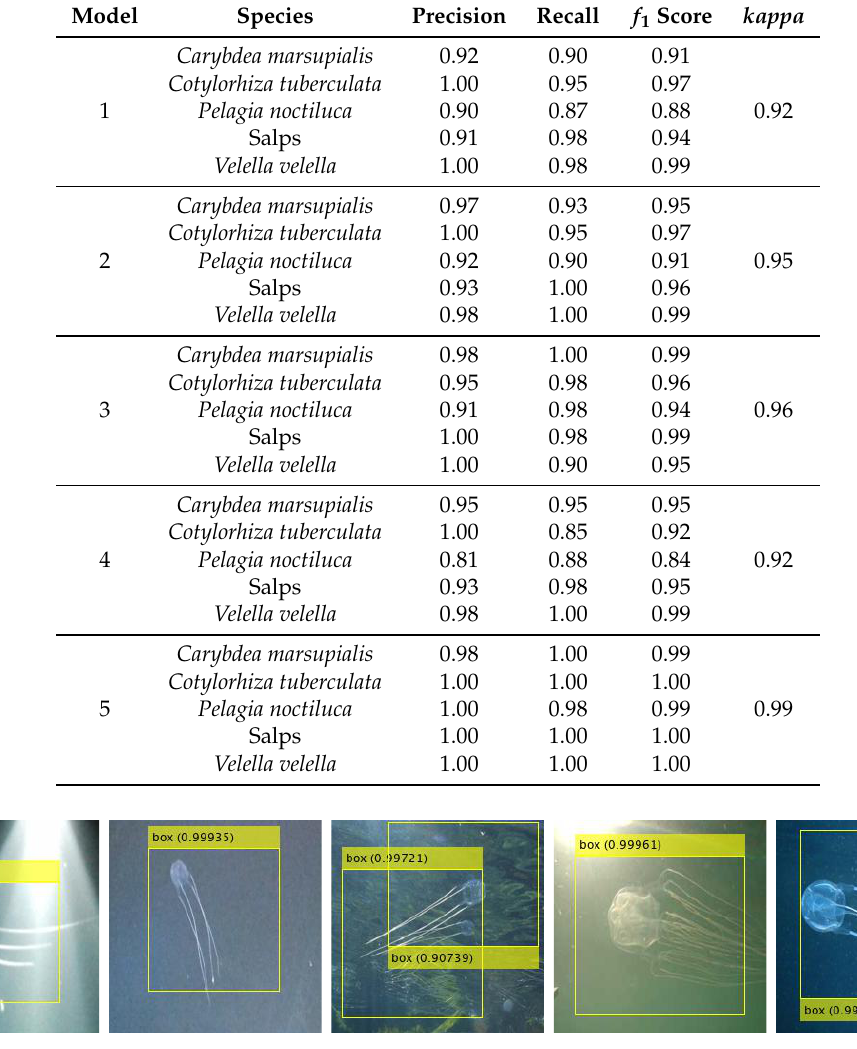
Table 4. Precision, recall, f 1 score and κ metrics for predictions by the five classification models.